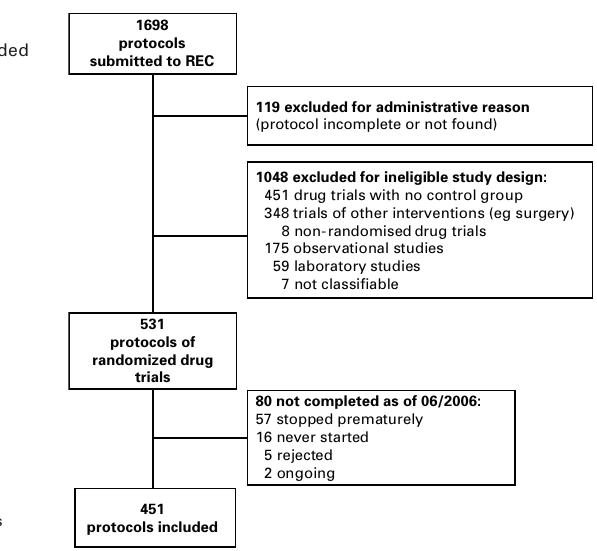
REC = research ethics